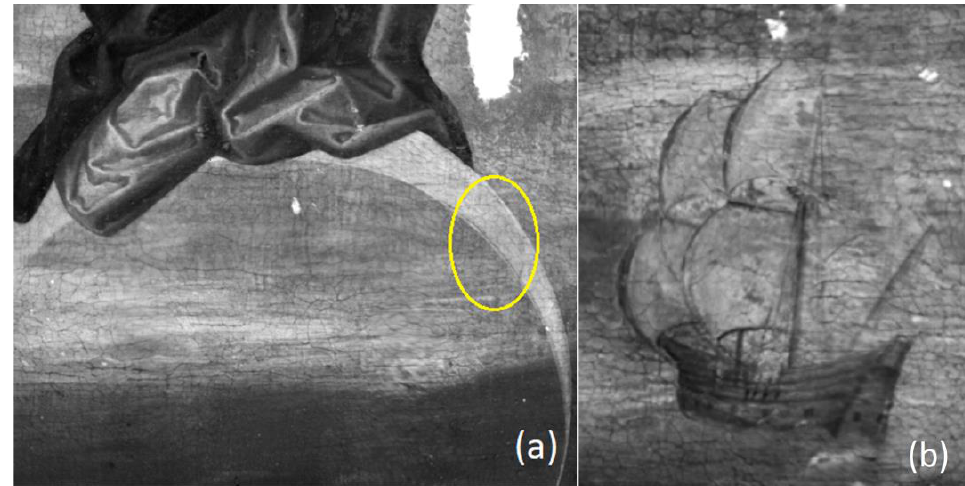
Figure 5. Detail of the IRR image, showing the underdrawing ( a ) on the half-moon and ( b ) for the design of the boat.